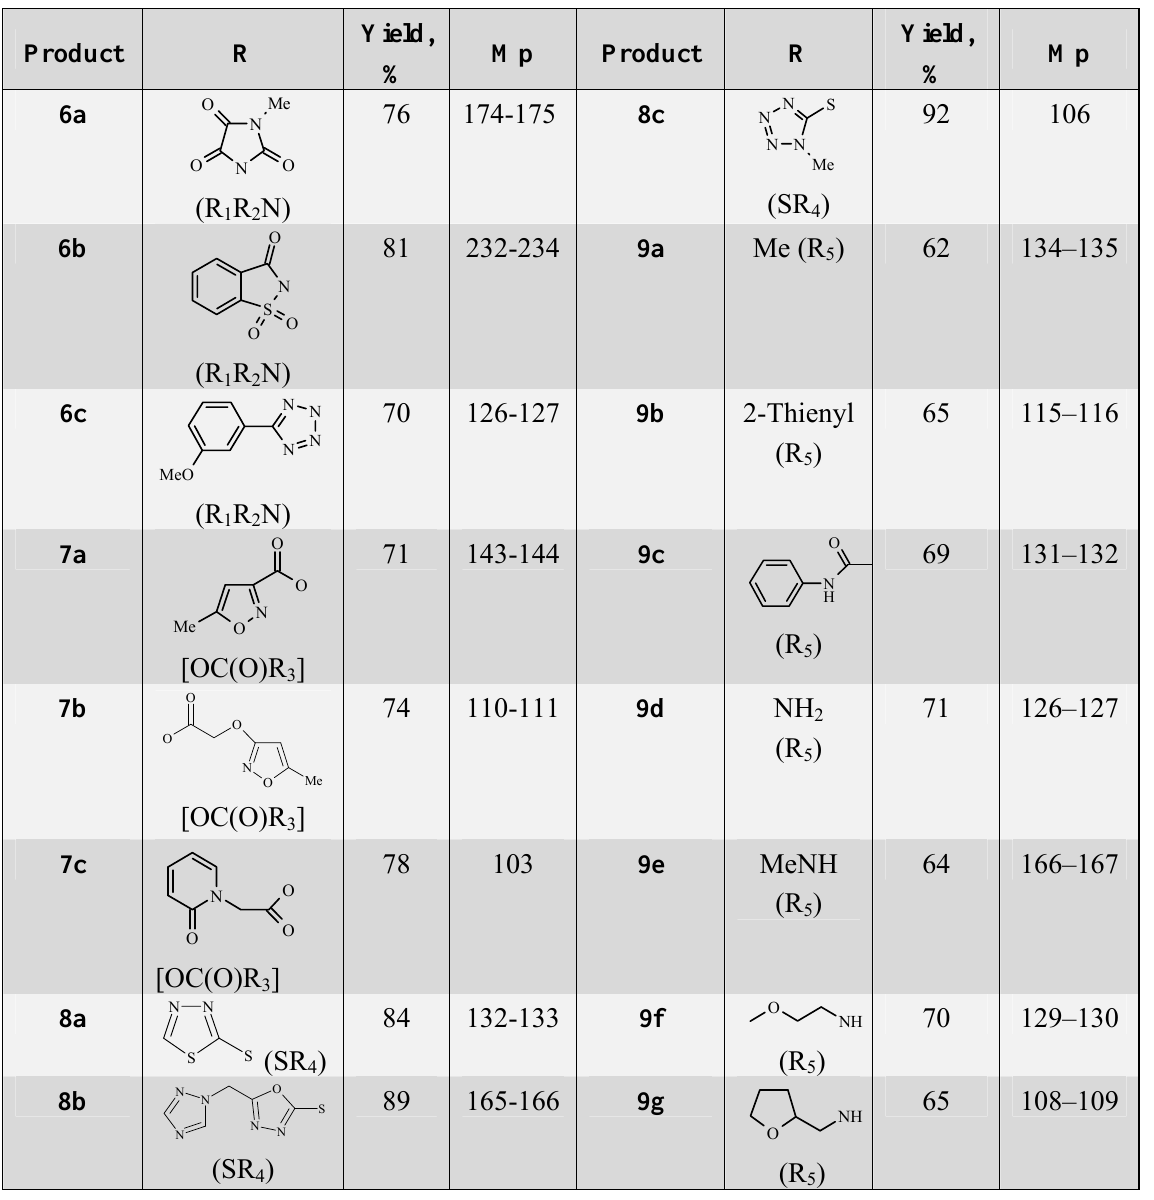
Table 1. Yields and melting points of the synthesized